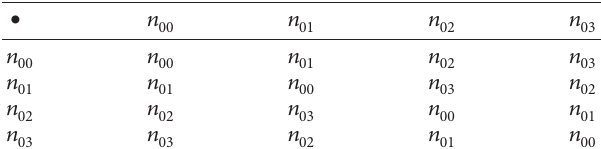
Table 6: Operator.